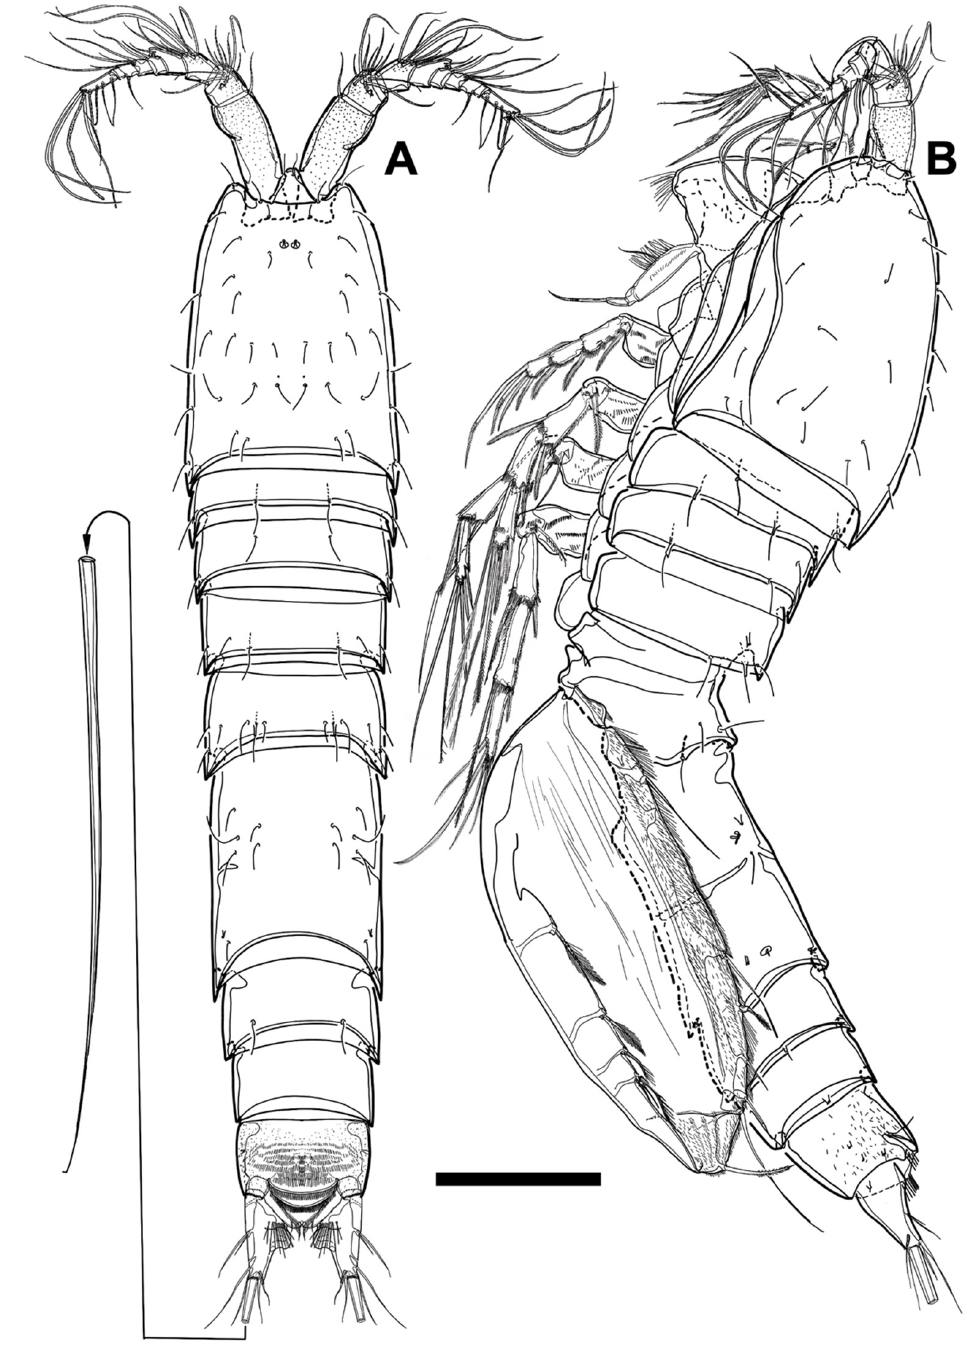
Figure 25. Line drawings of Phyllopodopsyllus similis sp. nov. female (holotype): ( A ) habitus; dorsal; ( B ) habitus, lateral. Scale bar: 100 µm.